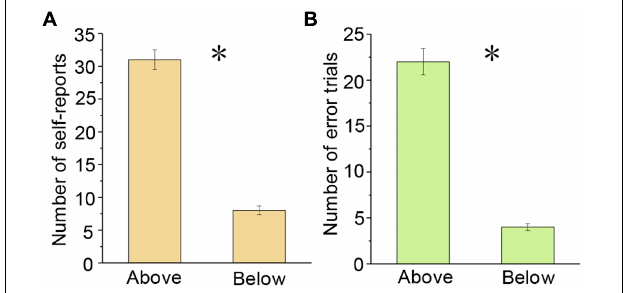
FIGURE 6 | Number of self-reports and error trials during trials above and below the (cid:49) TS ∗ . Participants (A) reported significantly more mind-wandering episodes and (B) made significantly more error trials during trials above the ∗ than those below the (cid:49) ∗ . ∗ p < 0.05. Error bars indicate ± SD (cid:49) TS TS